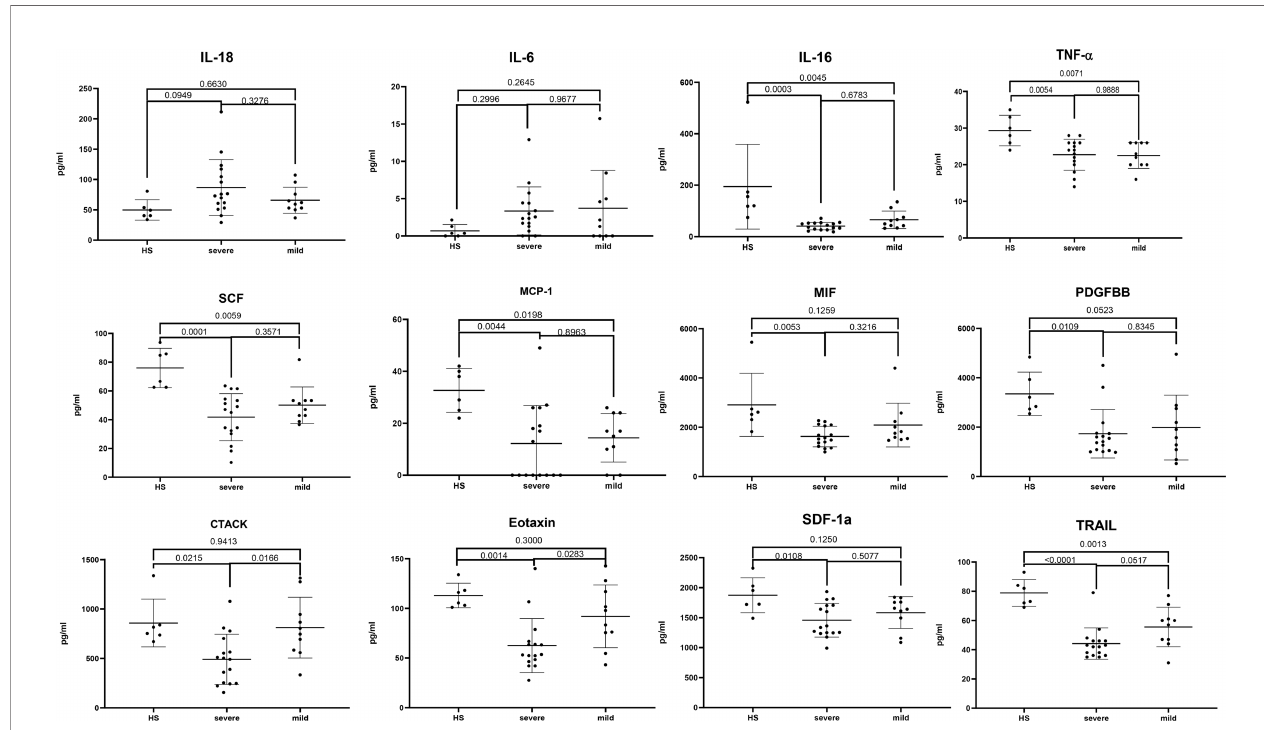
FIGURE 3 | The difference of main cytokines in plasma among healthy, mild, and severe patients. Series of cytokines in the plasma of healthy controls (n = 6); severe JE patients (n = 16, these data were from the plasma of JE cases on the fi rst day they were hospitalized) and mild patients (n = 10) were analyzed with ordinary one-way ANOVA Tukey ’ s multiple-comparison test. p <0.05 was considered statistically signi fi cant.